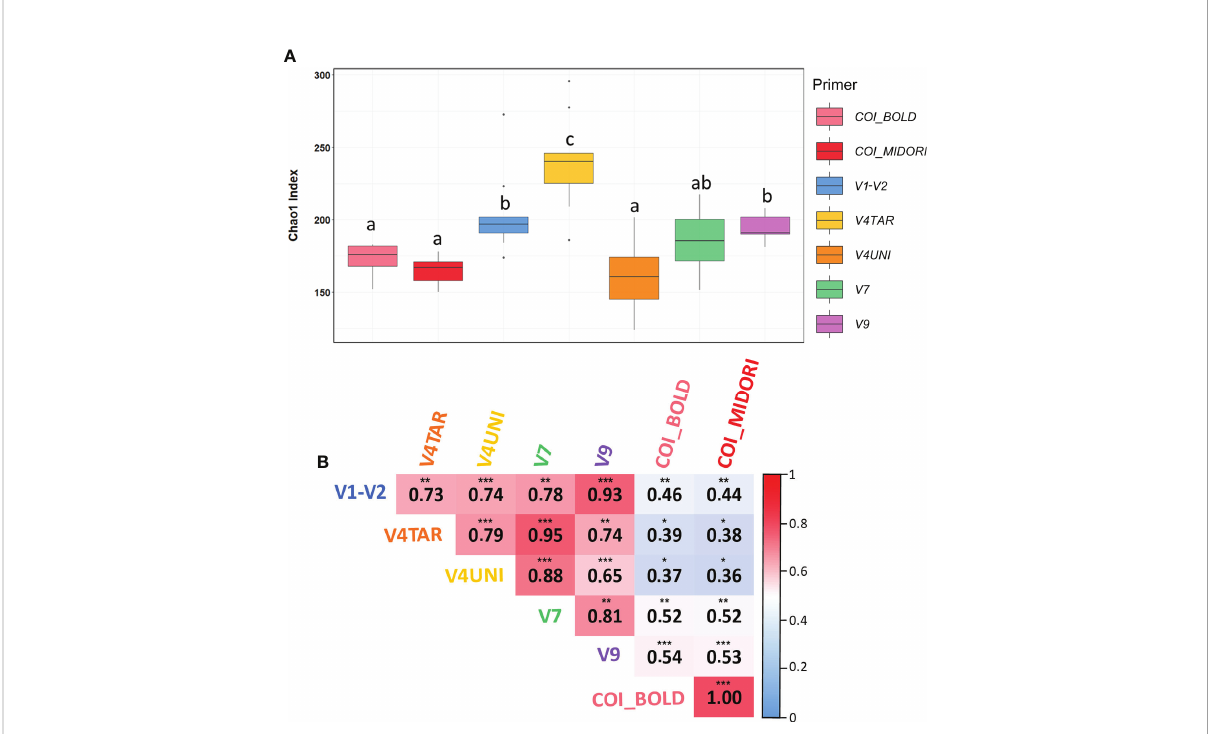
FIGURE 2 Diversity of eukaryotic communities according to different genetic markers. (A) Boxplots of chao1 index at the genus level for each primers pair calculated for Toulon samples. The line in each box plot indicates the median, the box delimits the 25 th and 75 th percentile, and the whisker is the range. Letters above boxplots represent pairwise comparisons between each primers pair. (B) Mantel test between eukaryotic community structures for each primer based on Spearman correlation for Toulon samples (n= 9). Color indicated the R values. Analyses are performed on Jaccard distances based on ASVs. Signi fi cant values are indicated by the following code: 0 ‘ *** ’ 0.001 ‘ ** ’ 0.01 ‘ * ’ 0.05 ‘ . ’ 0.1 ‘‘ 1. Samples used are the three panels (PVC, PA, and HDPE) from Toulon extracted with the PMS method and ampli fi ed with fi ve hypervariable regions of 18S rDNA and COI af fi liated with the two databases (n = 54)